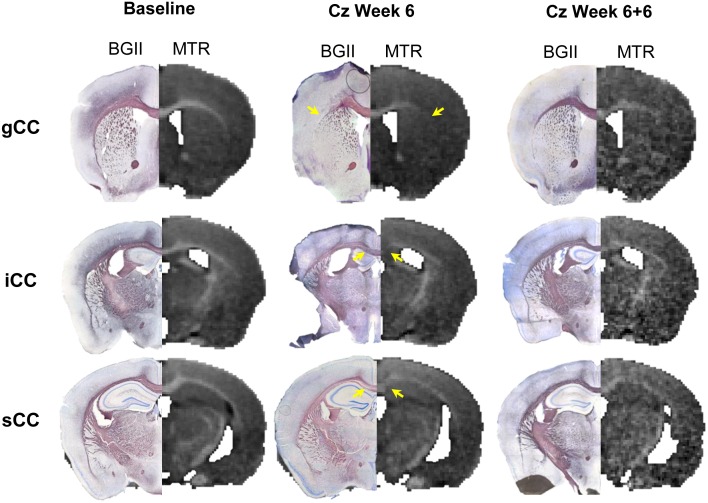
BGII/MTR Hybrid images.BGII sections compared to MTR maps in gCC, iCC, and sCC. Hybrid BGII/MTR images demonstrate MTR contrast and corresponding BGII staining at the level of gCC (first row), iCC (second row), and sCC (third row) at Baseline (left), Cz Week 6 (middle.), and Cz Week 6+6 (right). Loss of MTR contrast at Week 6 matches changes in BGII staining, representing demyelination (yellow arrows). The black circle in the cortex above gCC at Cz Week 6 is a coverslip bubble and should be ignored.